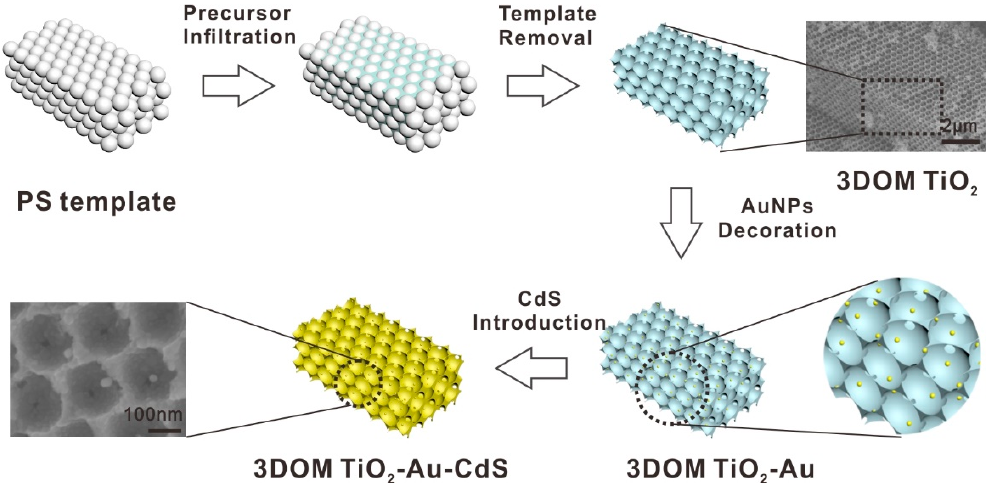
Figure 1. Schematic illustration of the 3DOM TiO 2 -Au-CdS preparation